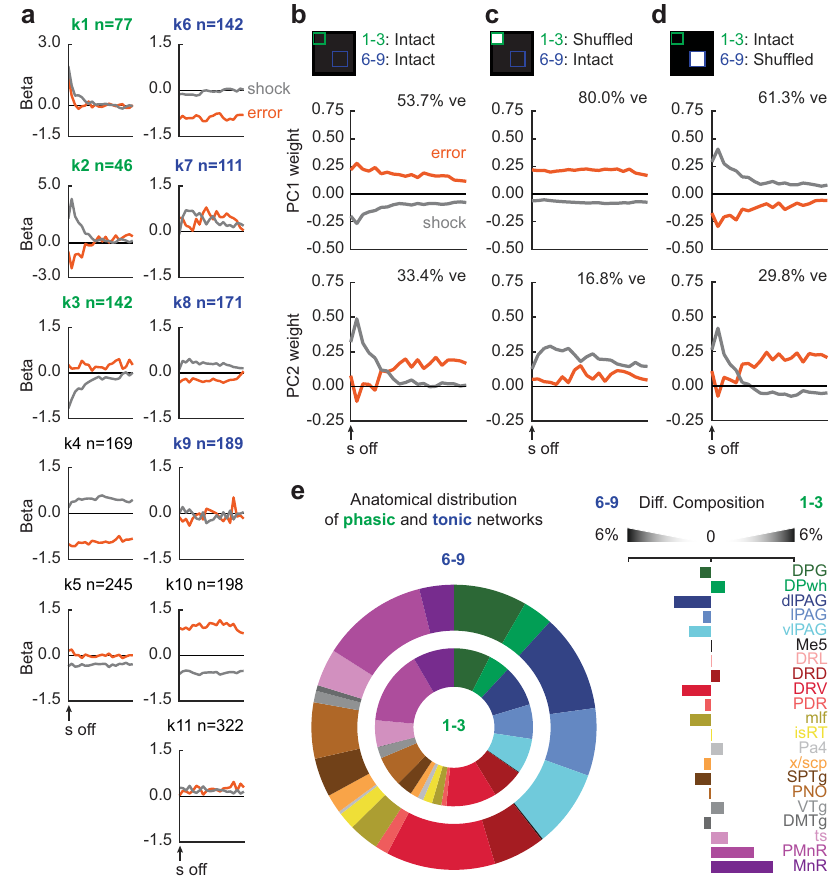
Fig. 5 | Brainstem prediction error and shock signaling. a Mean cluster (k1 – k11) beta weights for shockand prediction errorfollowing shockdeliveryand omission (cluster n shown in the fi gure). b Principal components for cluster beta weights (top; data from a ), resulting PC1 (middle), and PC2 (bottom). c Principal compo- nents for cluster beta weights with phasic outcome network shuf fl ed (top; data from a ), resulting PC1 (middle), and PC2 (bottom). d Principal components for